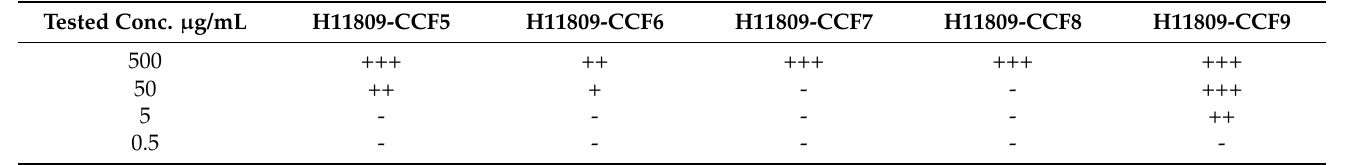
Table 2. Antimalarial activity of selected H11809-chloroform extract column chromatography fractions. Tested Conc. µ g/mL